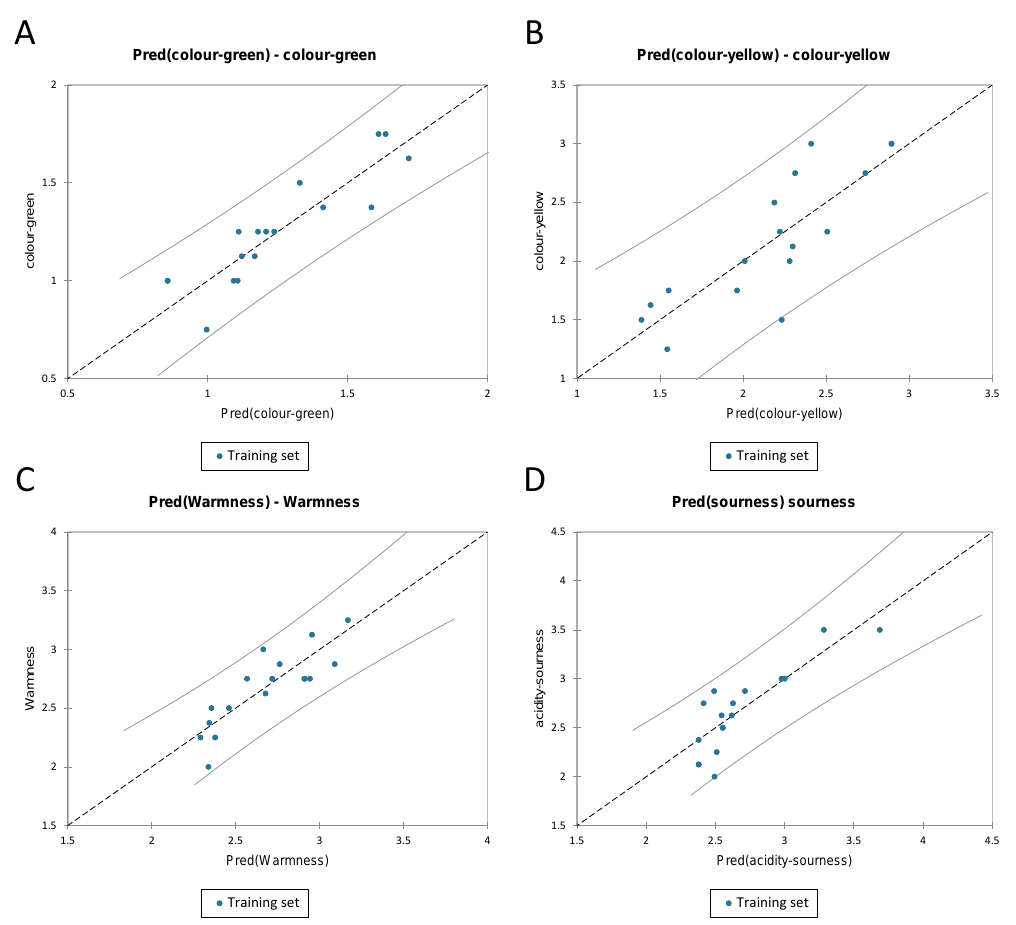
Figure 7. Model-predicted vs. observed visual and gustatory observations for Chardonnay wines. ( A ) predicted vs. experimental data graph for “colour green”, ( B ) predicted vs. experimental data graph for “colour yellow”, ( C ) predicted vs. experimental data graph for “warmness”, and ( D ) predicted vs. experimental data graph for